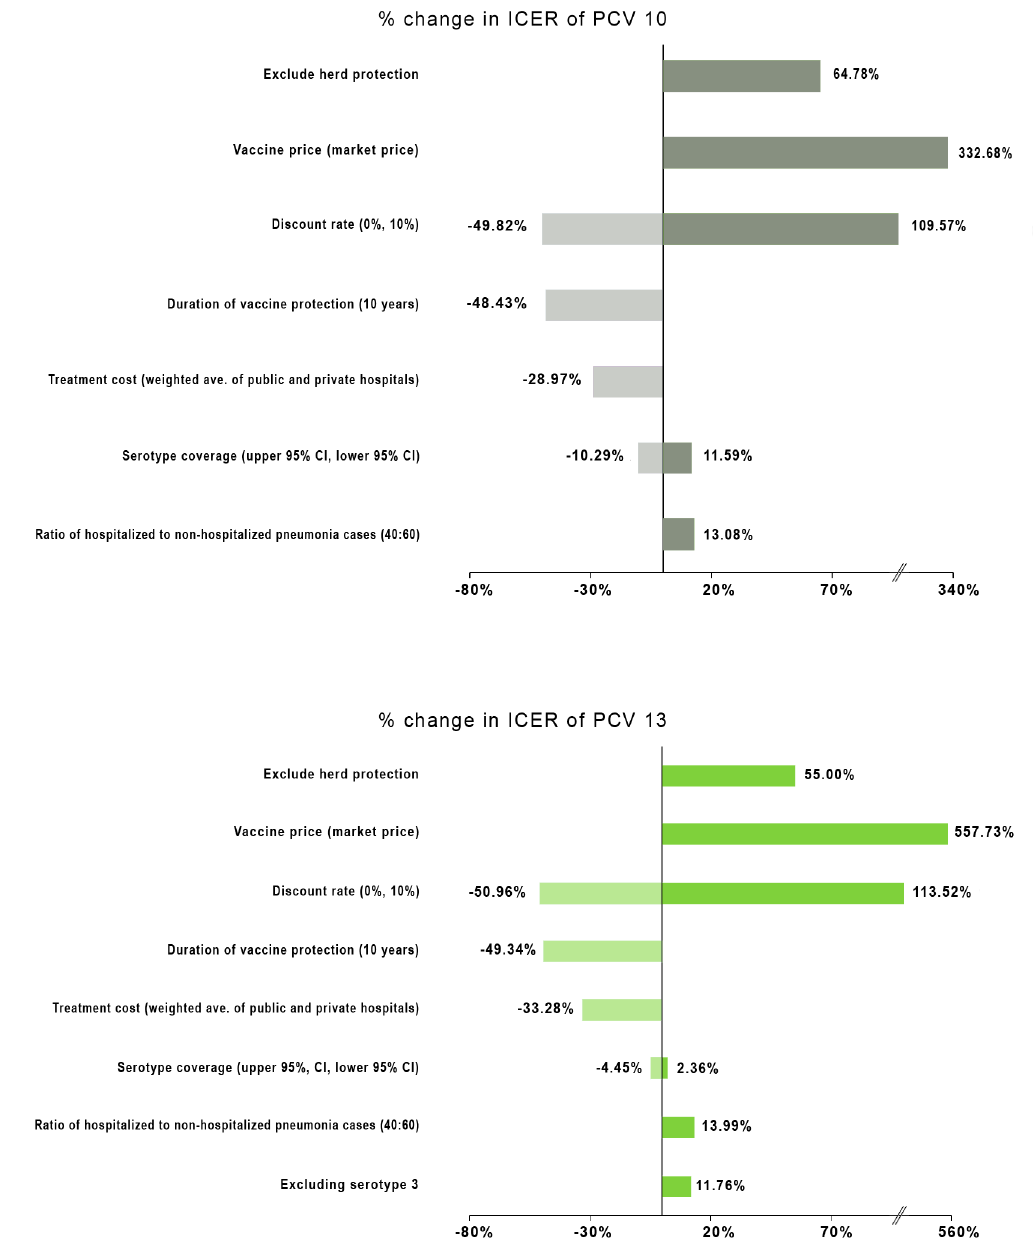
Fig 4. Tornado diagram for PCV10 and PCV13 versus no vaccination. Exploring the impact of uncertainty in key model parameters on ICERs of PCV10 (Php 68,182) and PCV13 (Php 54,510) in the scenario of universal